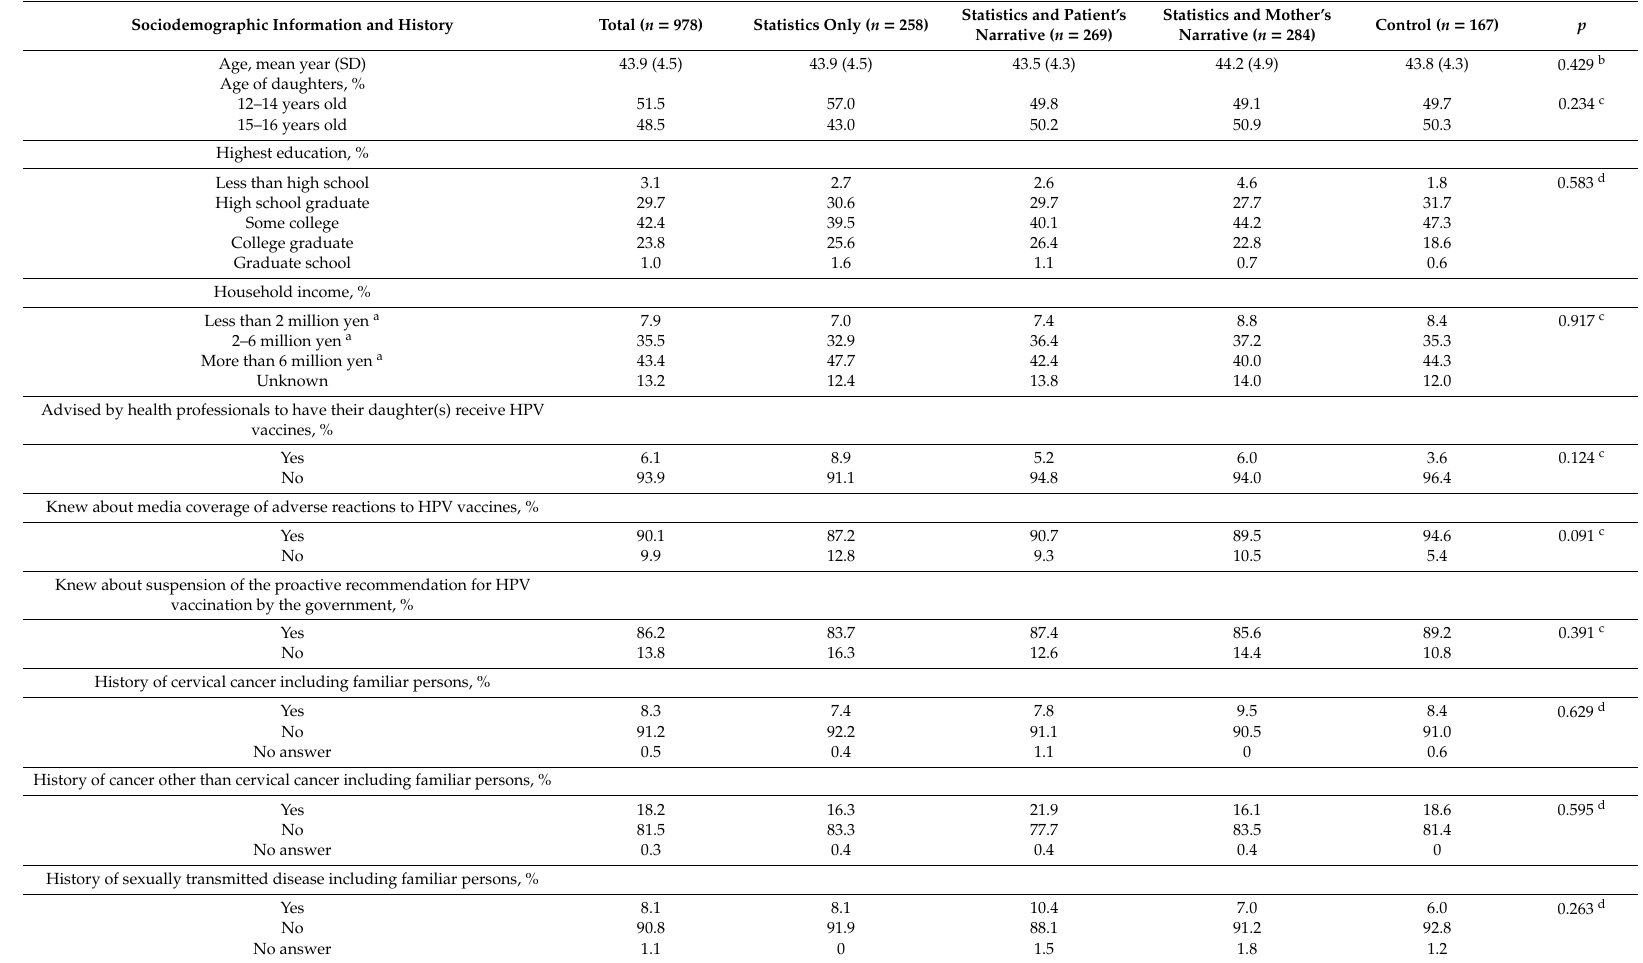
Table 1. Participant sociodemographic information and